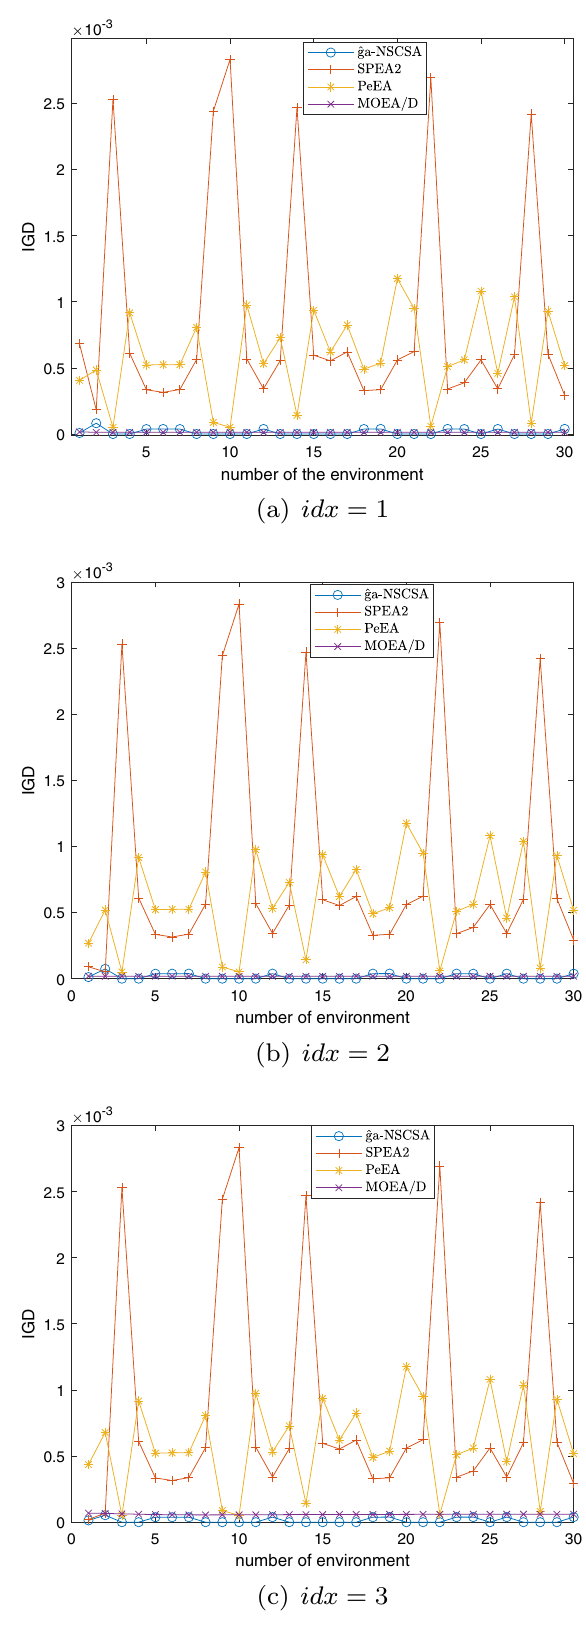
Fig. 11 The IGD values in all environments of Problem